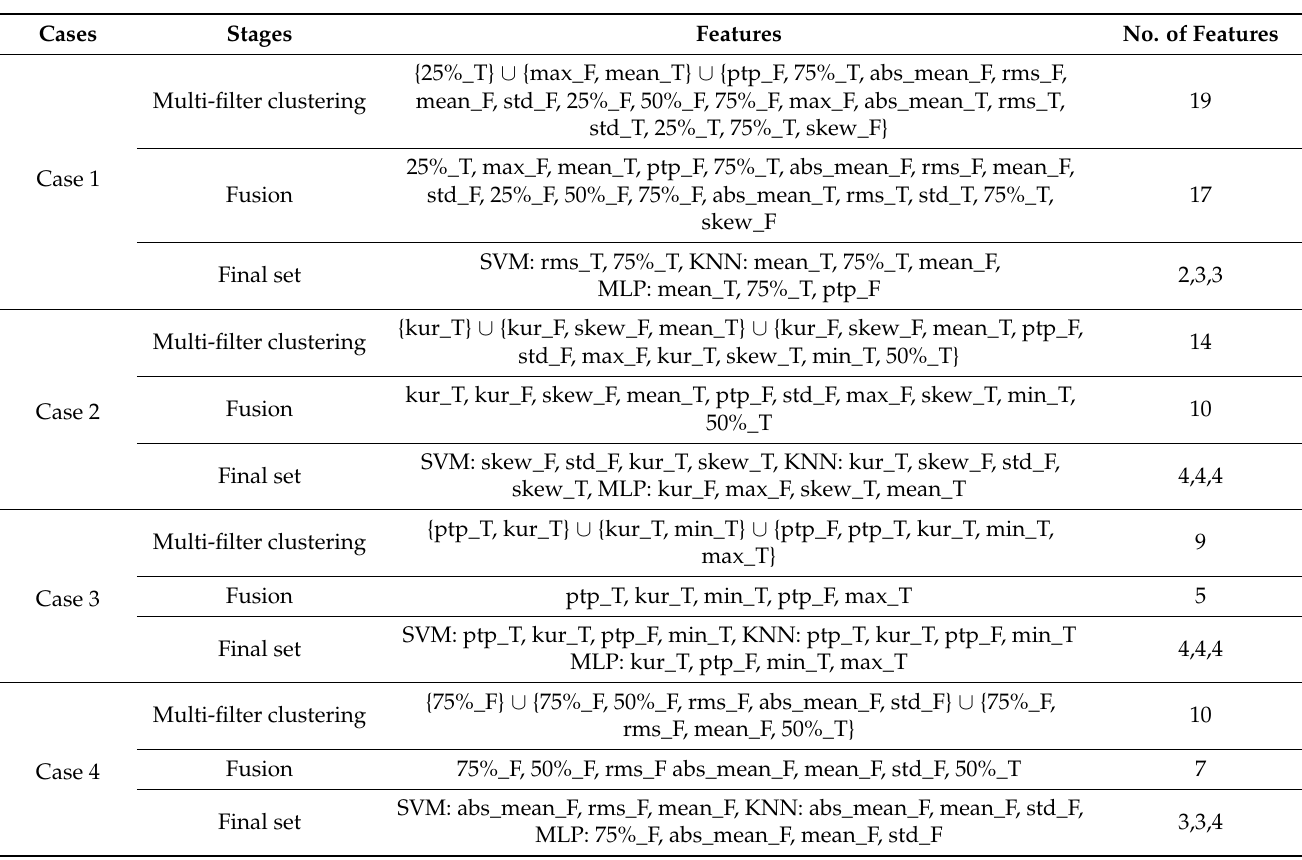
Table 4. Selected features at each